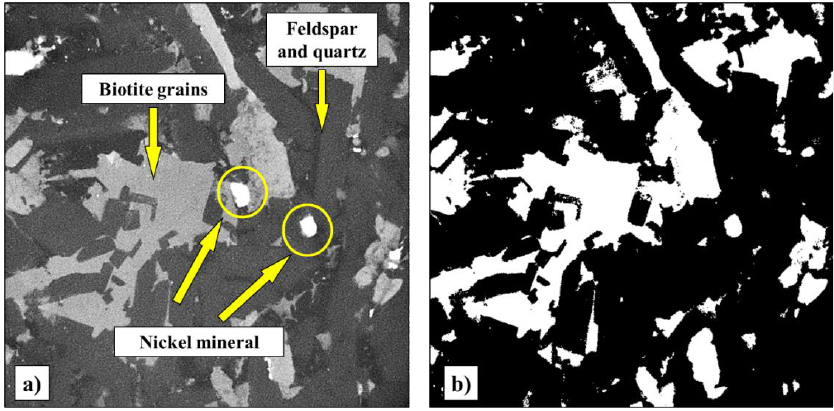
Figure 6. Norite after ( a ) 200 °C treatment and ( b ) binary image, at XY plane. To quantify the percentage of minerals, CT images were binarized using the threshold obtained from the Otsu algorithm. The “white” area indicates the biotite grain and the Ni, whereas the “black” area denotes the feldspar and the quartz. In particular, Figure 7 summarizes the percentage of the three mineral categories, based on pixels counting.